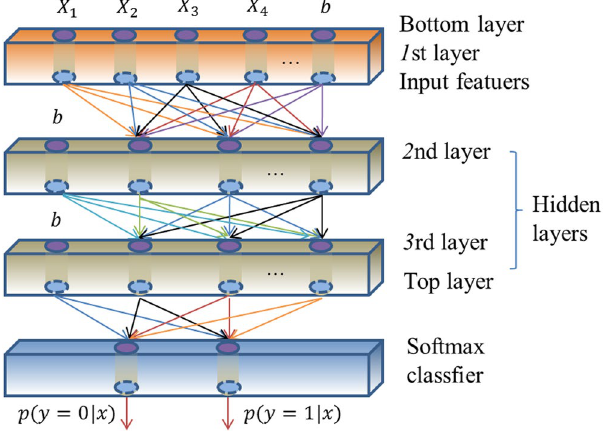
Figure 6. A sketch map of a deep sparse auto-encoder model with two hidden